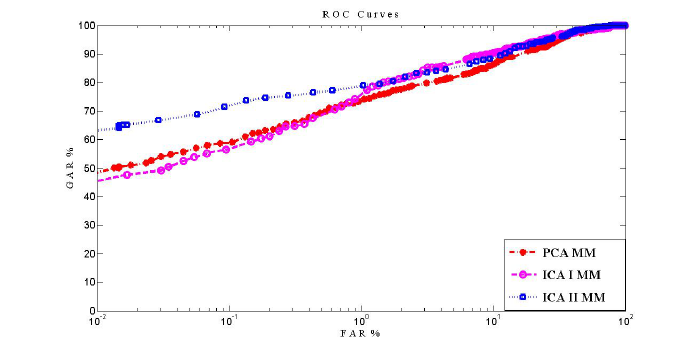
Figure 4. ROC curves for the proposed mixture model based approaches on Database I.